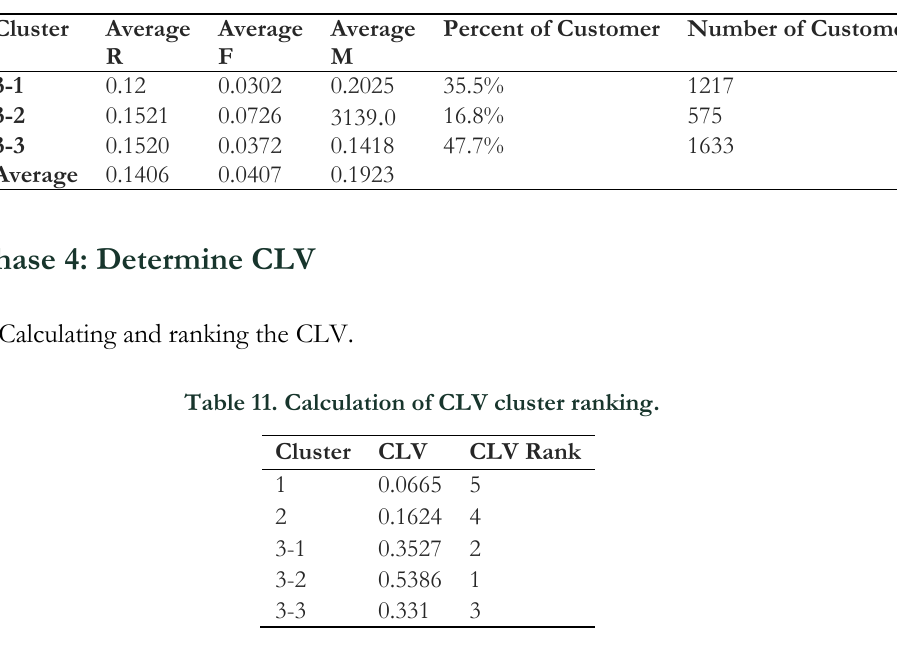
Table 10. Average value of RFM variable of the third cluster.